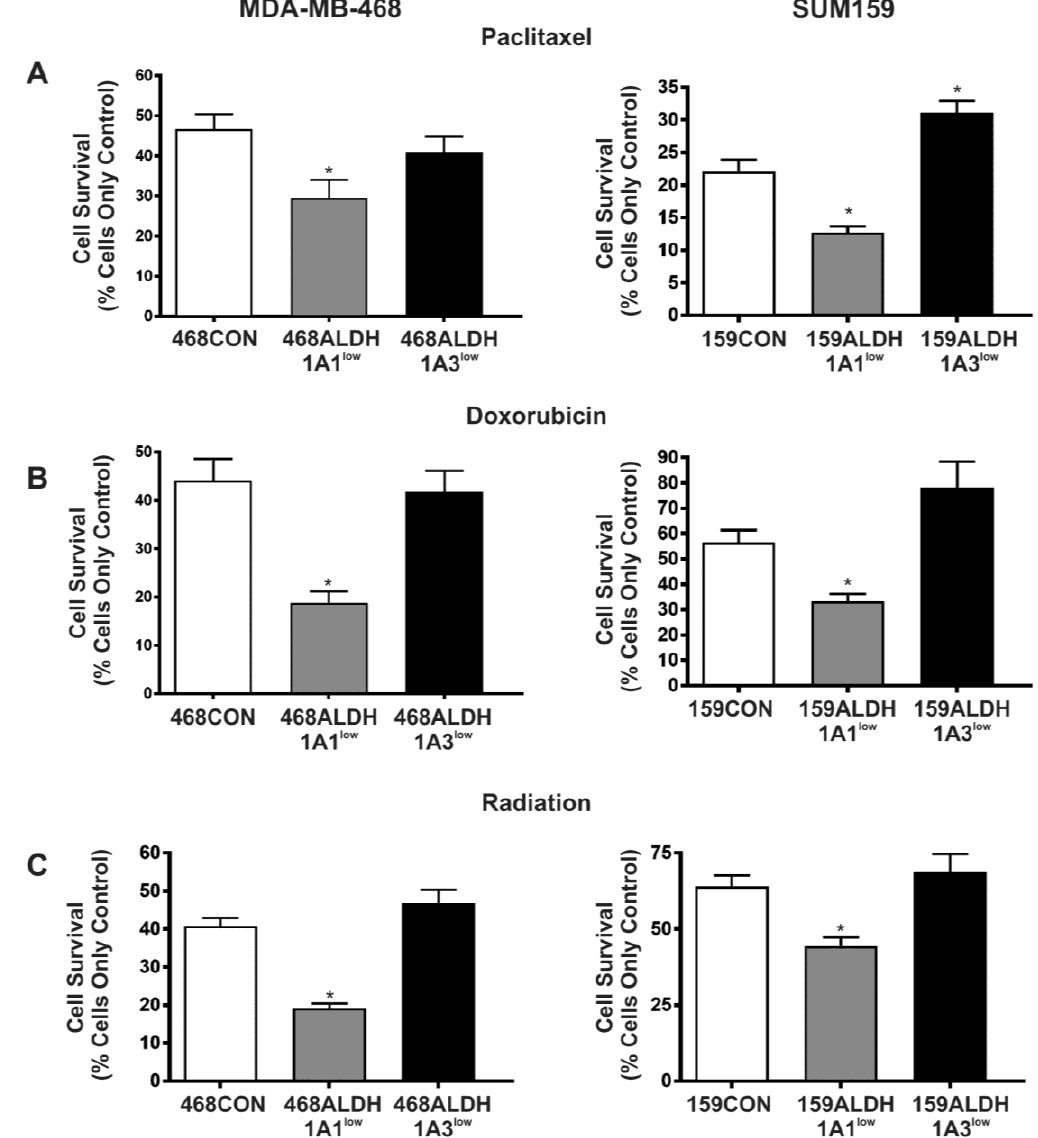
Figure 5. Decreased expression of ALDH1A1 but not ALDH1A3 sensitizes breast cancer cells to chemotherapy and radiation. MDA-MB-468 cells (left panels) and SUM159 cells (right panels) were treated with control siRNA (siCON) or ALDH-specific siRNA (ALDH1A1 or ALDH1A3) for 96 hours to generate the following cell lines: 468CON, 468ALDH1A1 low , 468ALDH1A3 low , 159CON, 159ALDH1A1 low , 159ALDH1A3 low . Cell populations were treated with ( A ) paclitaxel (0.2 μg/mL), ( B ) doxorubicin (0.2 μg/mL), or ( C ) radiation (2 × 5Gy; MDA-MB-468 or 2 × 15Gy; SUM159). Data represents the mean ± SEM normalized to respective control cells. * = significantly different than respective 468CON or 159CON cells treated with paclitaxel, doxorubicin, or radiation ( p < 0.01).